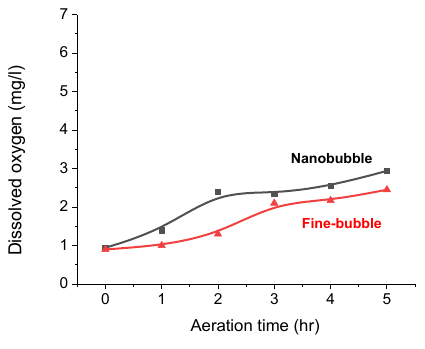
Fig. 3. Changes in Dissolved Oxygen in Reactor Mixed Liquor (SRT=20 d, COD=800 mg/l)